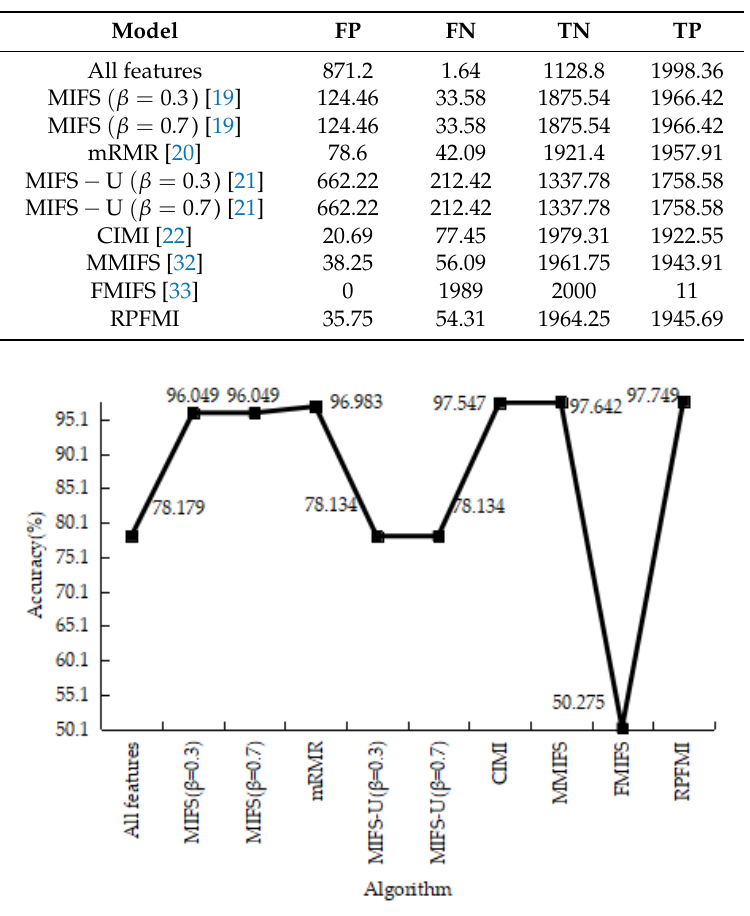
Figure 13. Accuracy on the Kyoto 2006+ test data.